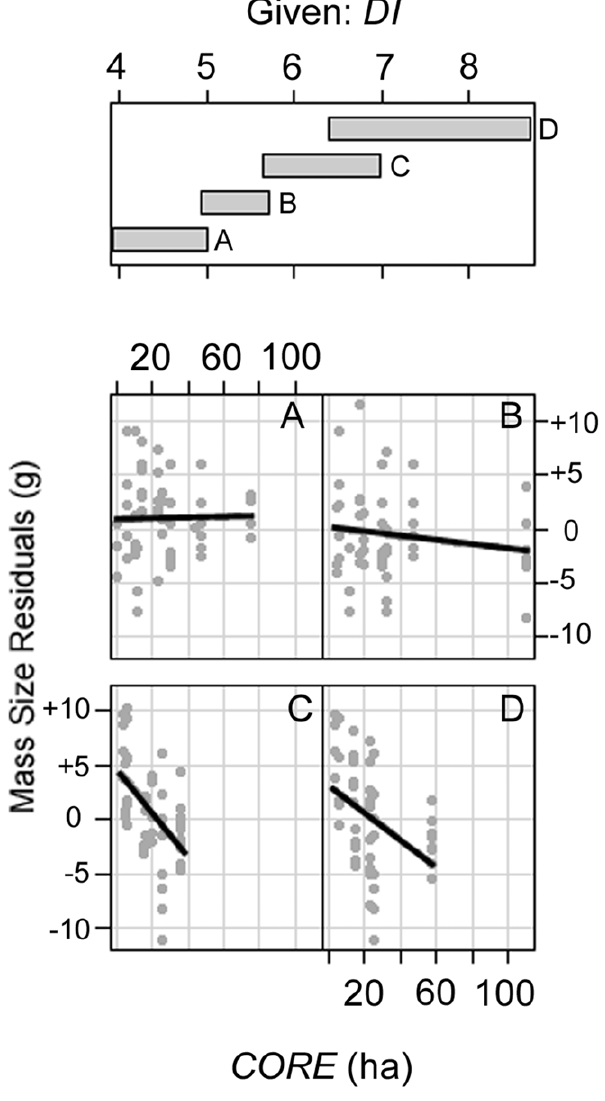
Figure 2. Conditioning plot of CORE (ha) given DI for male body condition index (MSR). The top box shows regions of DI for which MSR is plotted against CORE . The overlap in DI is 25%.